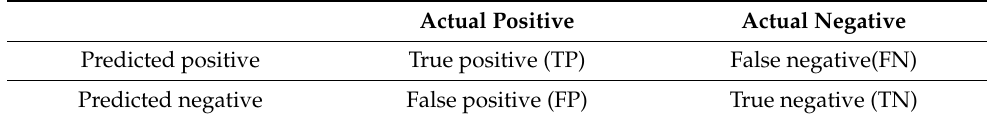
Table 2. Confusion